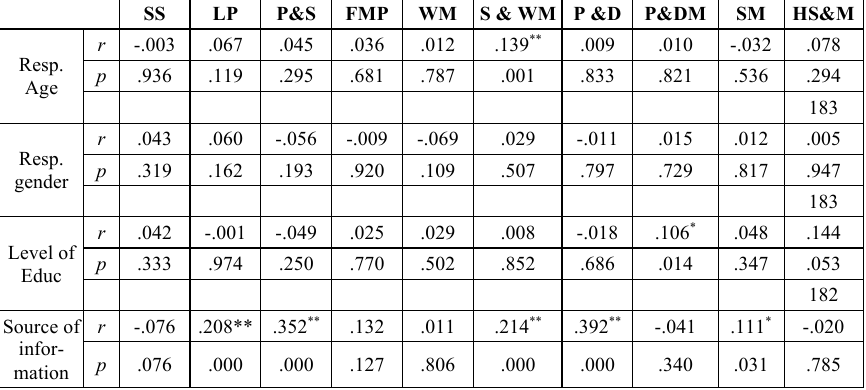
Table 3. The influence of socio-economic characteristics on knowledge gain by smallholder banana